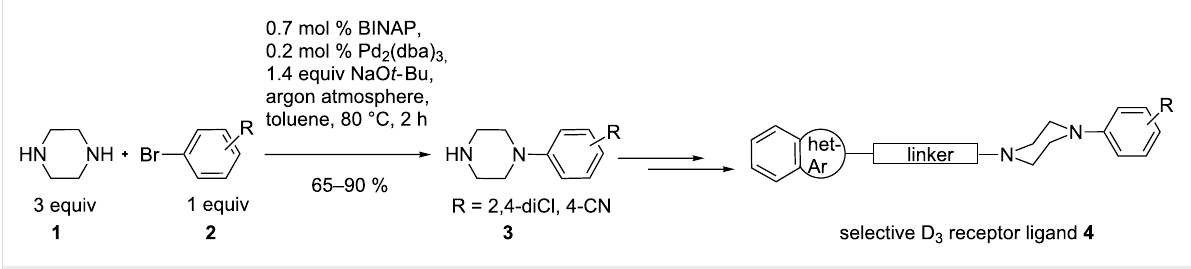
Scheme 1: Synthesis of selective D 3 receptor ligands.